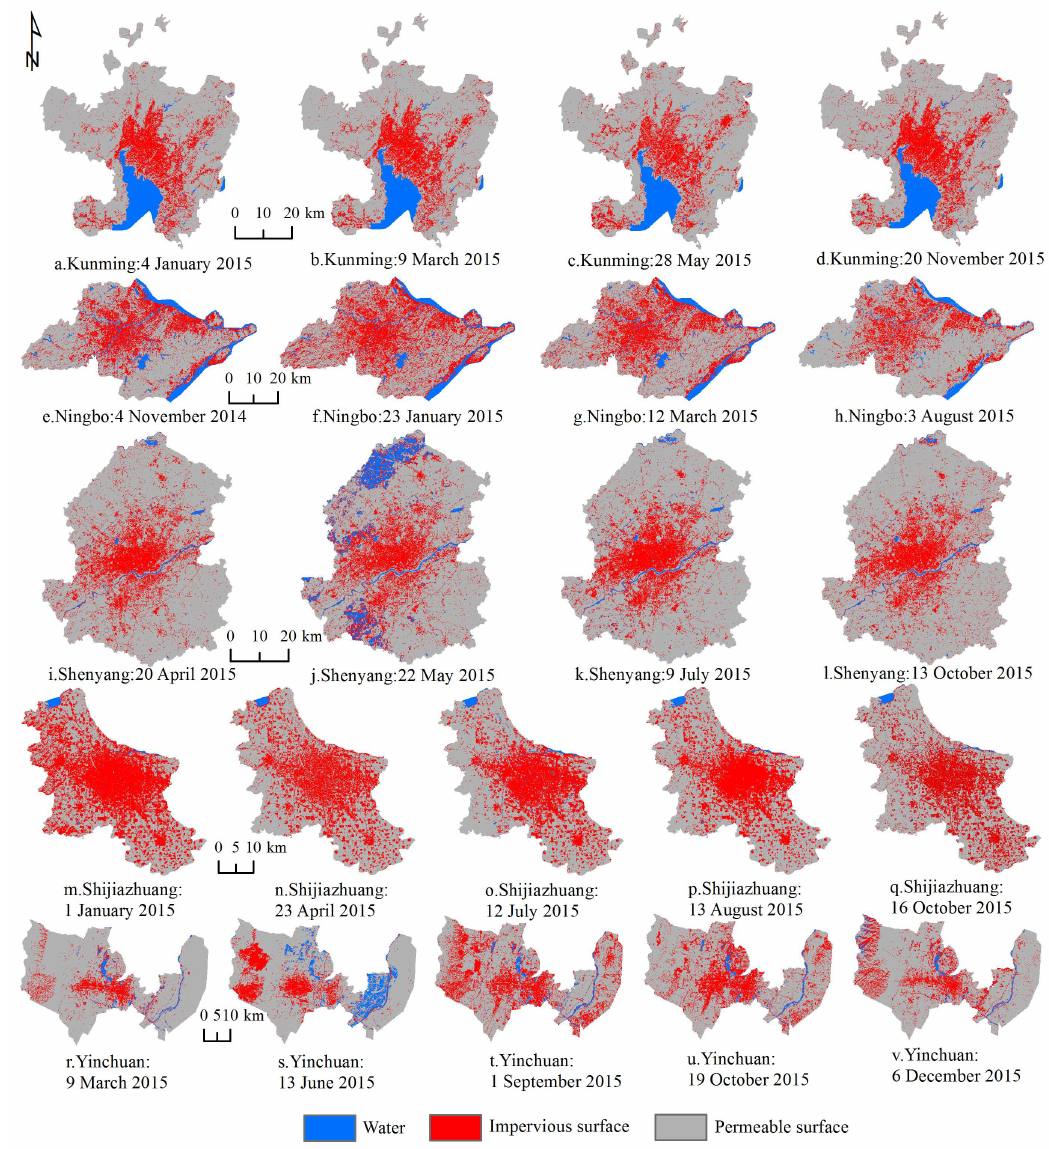
Figure 7. Impervious surface classification for five cities at different time points. Red indicates the impervious surface class; gray indicates permeable surfaces; and blue indicates